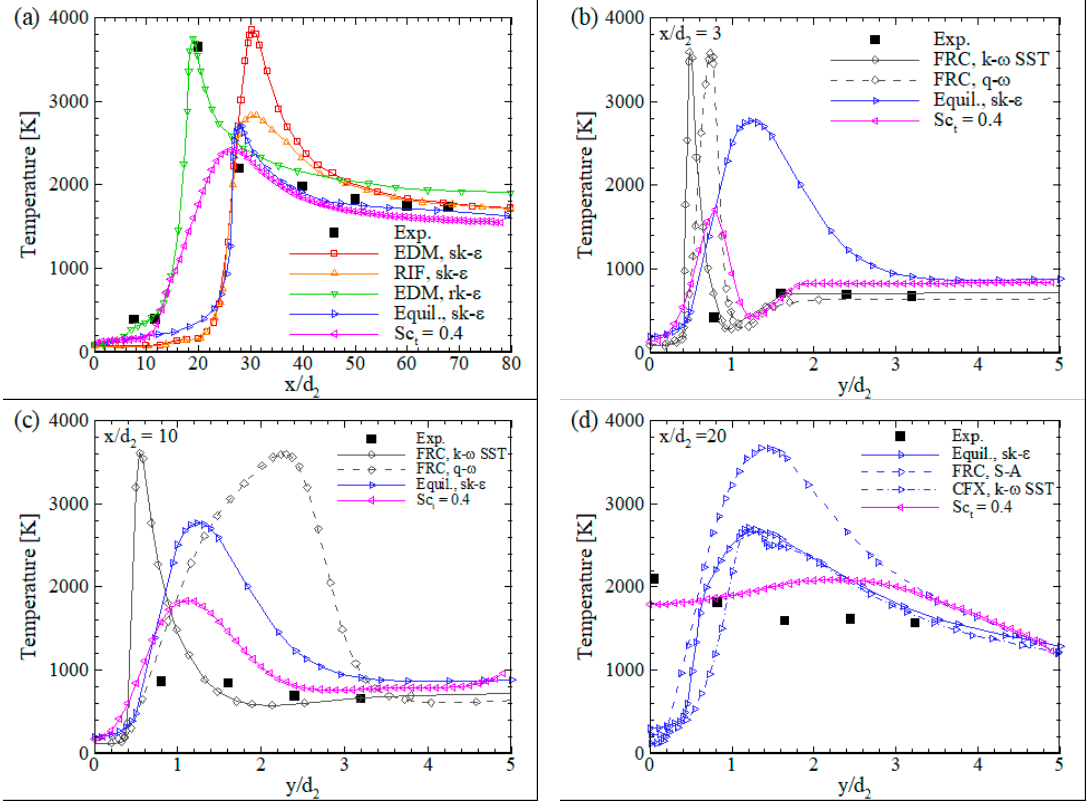
Figure 15. Time-averaged temperature profiles: ( a ) along central-axis; ( b ) at x / d 2 = 3; ( c ) at x / d 2 = 10; ( d ) at x / d 2 = 20, including profiles from previous studies.